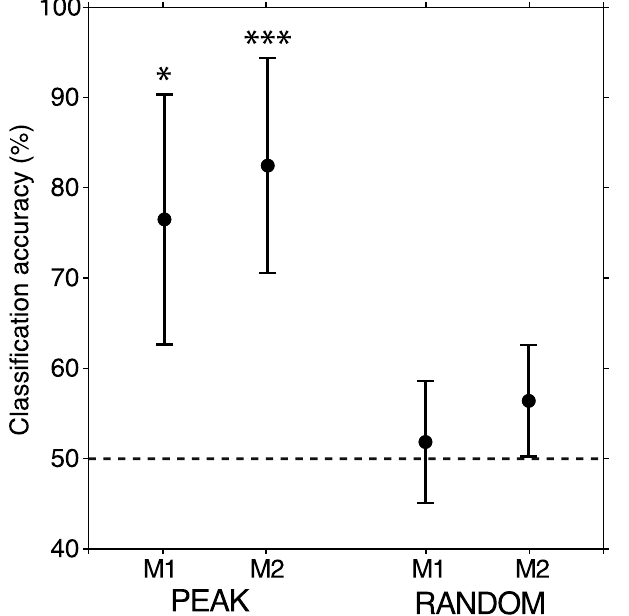
Figure 7. SVM Classification of Task Contingency. Classification accuracy ± s.e.m. based on V1/V2- extrastriate top-down narrow-beta-band sGC peak magnitudes (left group) and randomly selected sGC magnitudes between 5 and 50 Hz (right group). The top-down sGC peak-based classifier significantly exceeded chance (dashed line) for M1 (76%, t(10177) = 2.05, p = 0.020) and M2 (82%, (t(8266) = 2.70, p = 0.004). The SVM classifiers based on randomly selected magnitudes were near the chance level